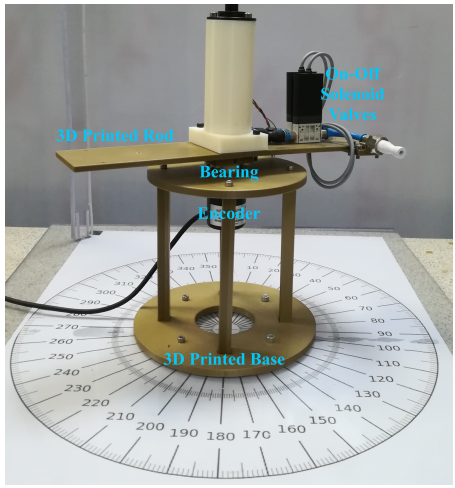
Figure 6. Single axis test platform.